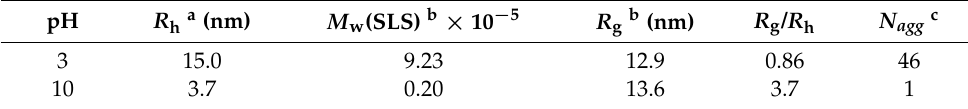
a Estimated from dynamic light scattering (DLS); b Estimated from static light scattering (SLS); c Aggregation number calculated from M w of the aggregate determined at pH 3 and M w of the corresponding unimer at pH 10 determined from SLS.